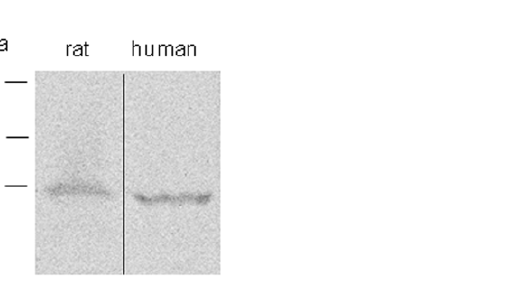
Figure 13. D3 detection by Western Blot in the rat and human hypothalamus. Note that the human D3 protein runs slightly faster compared to rat D3, in agreement with the calculated , 3 kDa size difference between the two